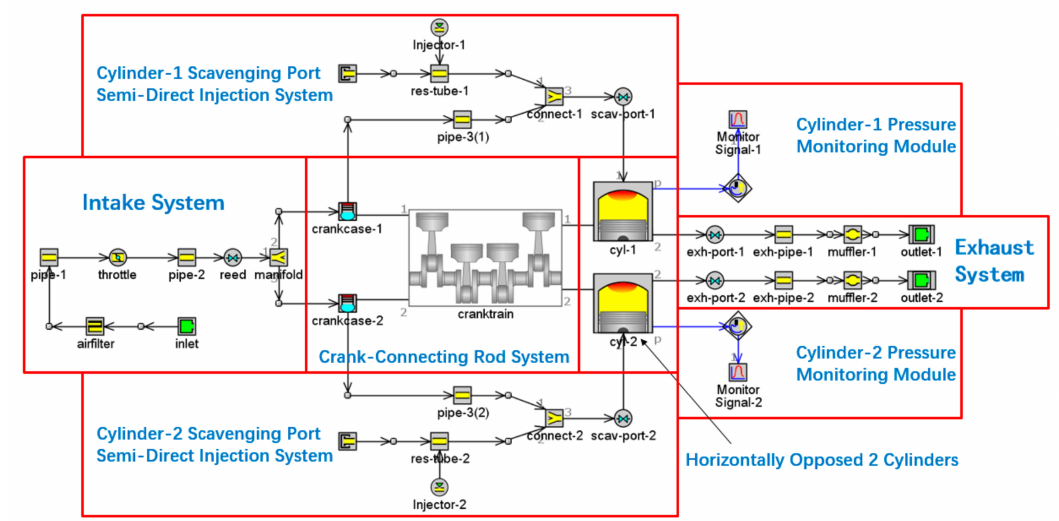
Figure 26. The layout of the integrated simulation platform in GT-ISE (retrofitted engine).